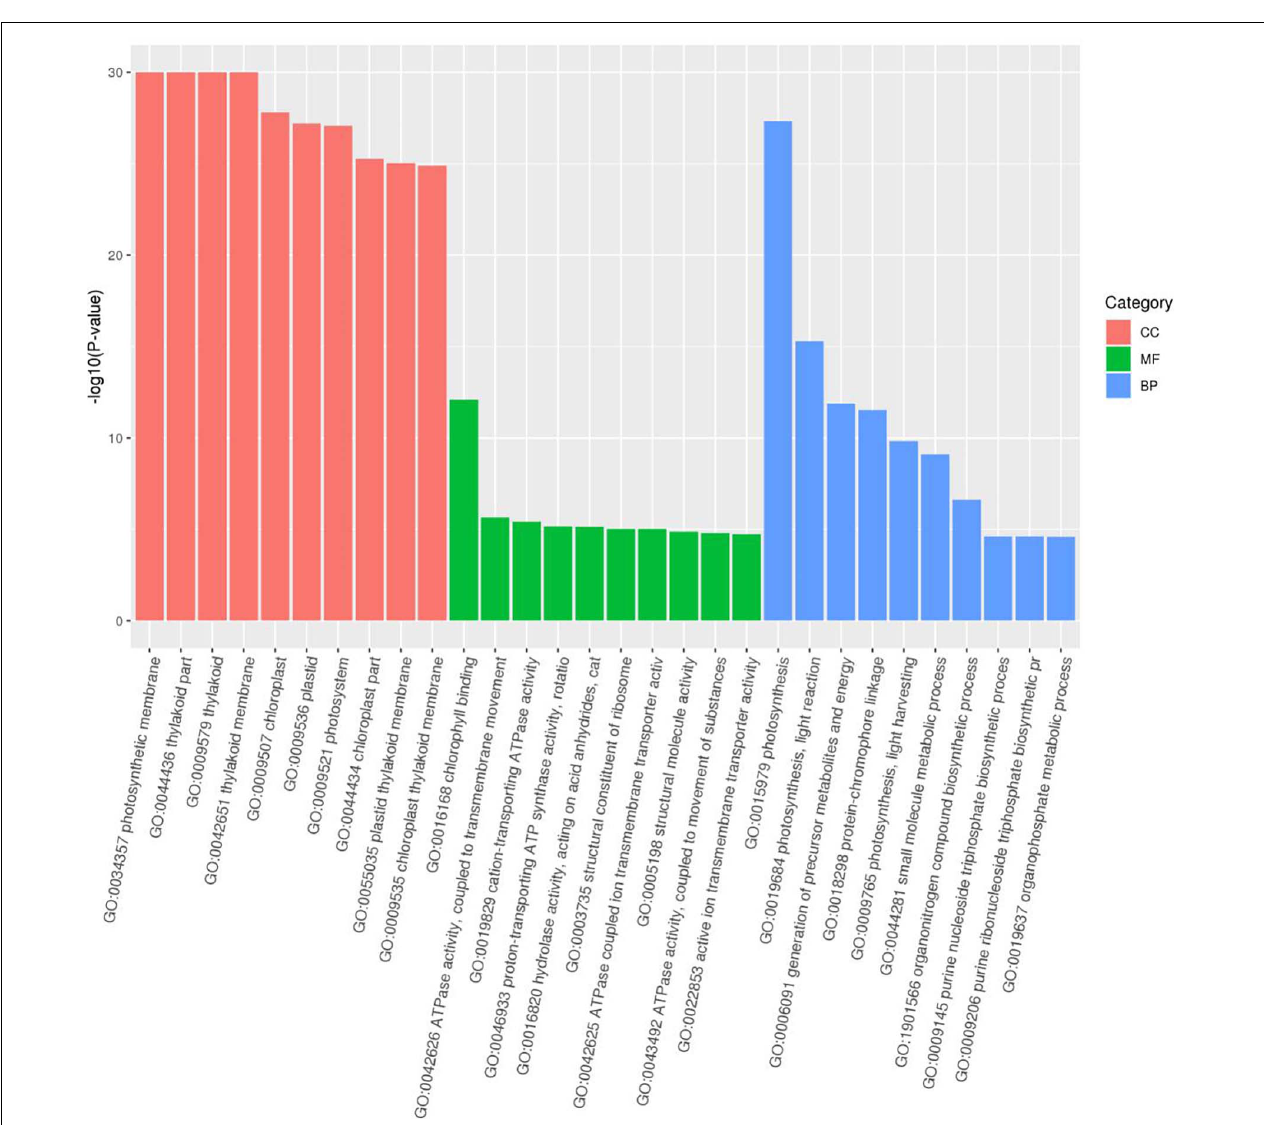
FIGURE 8 | Gene Ontology (GO) functional classification of